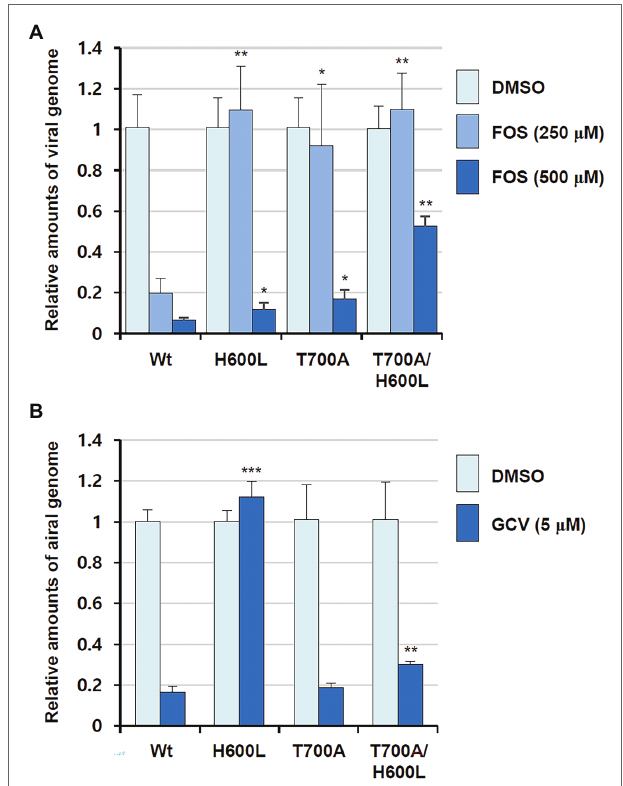
FIGURE 2 | Effects of foscarnet (FOS) and ganciclovir (GCV) antivirals on viral DNA levels in wild type and UL54 mutant virus-infected cells. HF cells (2 × 10 5 ) were infected with wild type or mutant (H600L, T700A, or H600L/ T700A) viruses at an MOI of 0.1 (IFU/ml) as indicated and incubated for 6 days in the absence or presence of 250 or 500 μ M FOS (A) or 5 μ M GCV (B) . Total DNA was isolated in cells and the amount of viral DNA level was measured using qPCR (see Materials and Methods). Statistical significance was determined between the wide type and each mutant virus at given drug concentrations and the values of p < .05 (*), <.01 (**), or <.001 (***) are